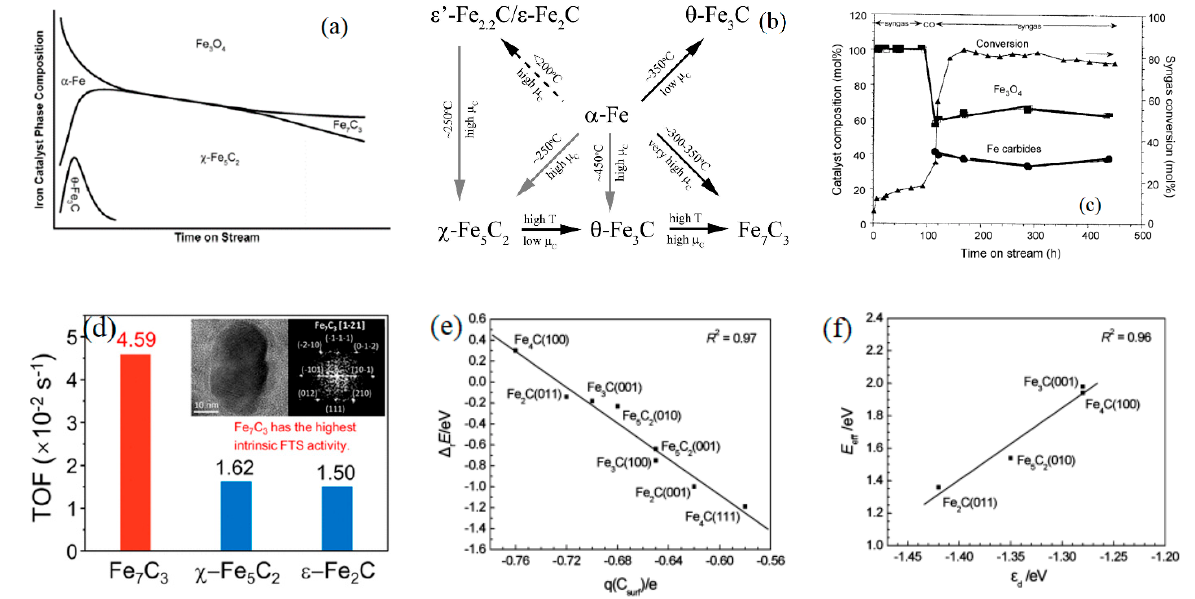
Figure 2. ( a ) Iron carbide structures vary with reaction time (from [11]), ( b ) Iron carbide structures and thermodynamics (reproduced with permission from [12] Copyright 2010, Elsevier), ( c ) iron phase composition and activity (reproduced with permission from [13] Copyright 2009, Elsevier), ( d ) Activity as a function of iron carbide type (reproduced with permission from [14] Copyright 2018, ACS), ( e ) bottom-middle and ( f ) Relationships between reaction energy ( ∆ r E ) of CH 4 formation and Mulliken charge ( q ) of the surface C atom as well as effective barrier ( E eff) of CH 4 formation and d-band center ( ε d) of the surface. (reproduced with permission from [16] Copyright 2009, ACS).